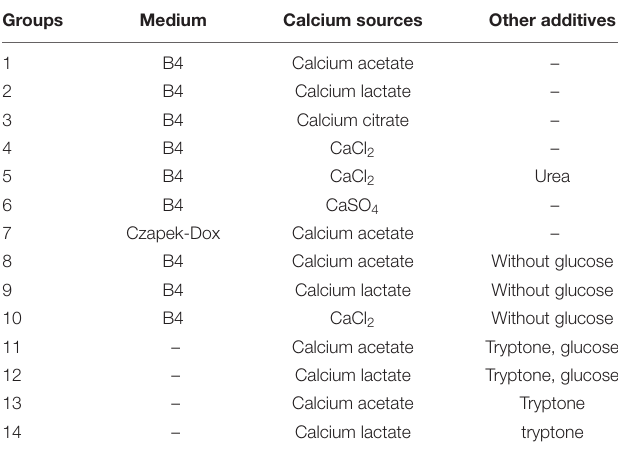
TABLE 1 | The composition of media under different